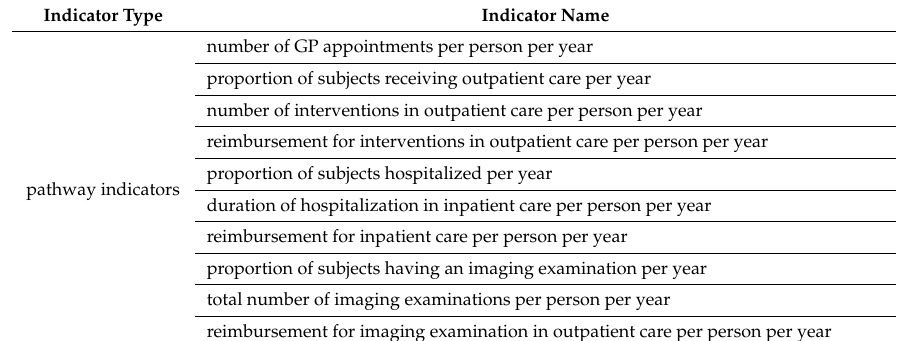
Table 1. Pathway, performance and all-cause premature mortality indicators for adults living in segregated Roma settlements (SRSs) and living in the same municipalities’ complementary areas (non-SRSs) with the age- and sex-standardized relative rates (RRs) in care for inhabitants of